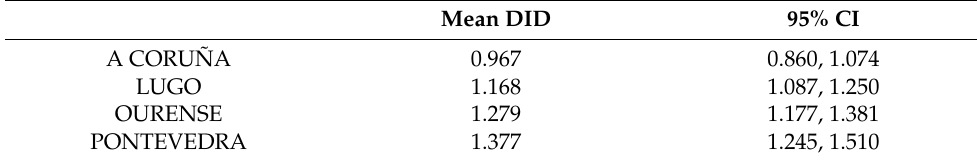
Figure 1. Distribution of defined daily dose per 1000 inhabitants per day (DID) by province. Table 1. Mean values and confidence intervals (95% CI) of the defined daily dose per 1000 inhabitants per day (DID) by province.